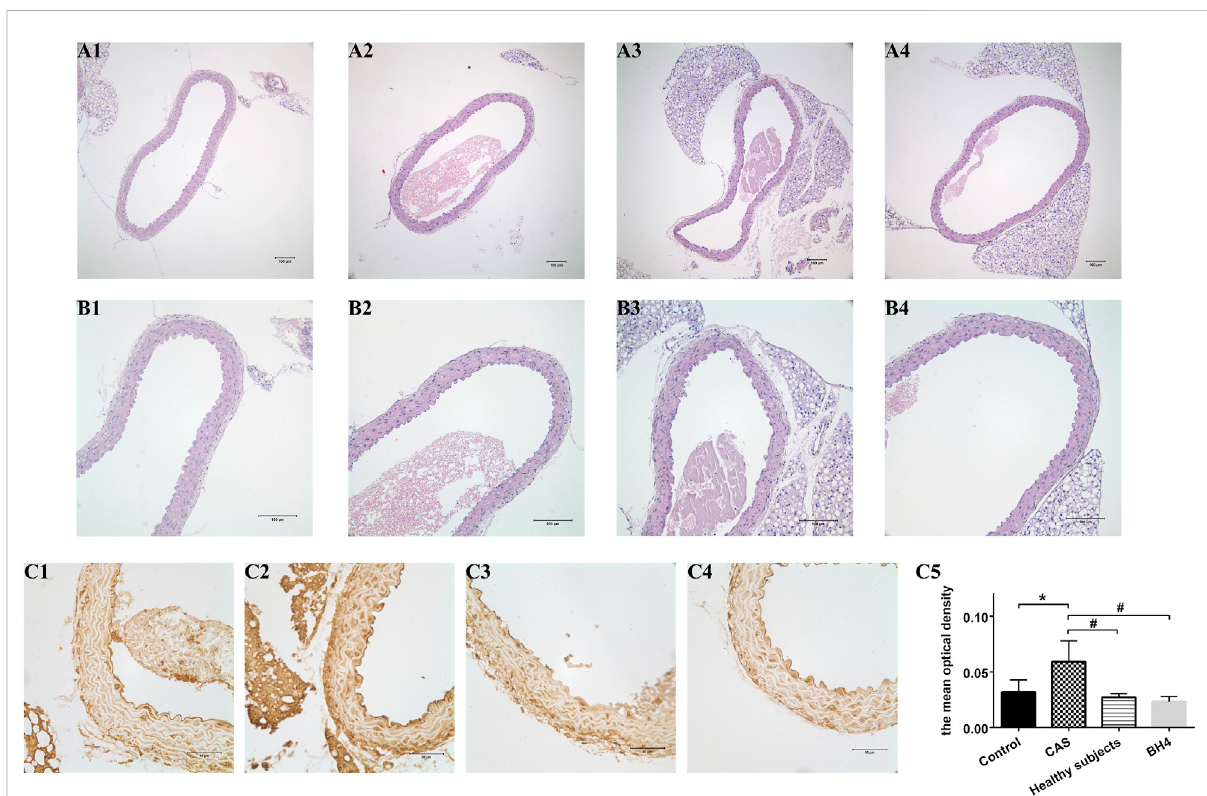
FIGURE 6 Pathology of mice aorta using HE staining (A1 – B4) and the expression of VCAM-1 in the intima (C1 – C4) . (A1 – C1) The saline control group. (A2 – C2) The CAS group. (A3 – C3) The healthy subjects. (A4 – A4) The BH4 group. (C5) The mean optical density of VCAM-1 in the intima of four groups [ n = 7 per group; (A1 – A4) ×100, (B1 – B4) ×400]. Values are shown as means ± SD. * p < 0.05 vs. the control group; # p < 0.05 vs. the CAS